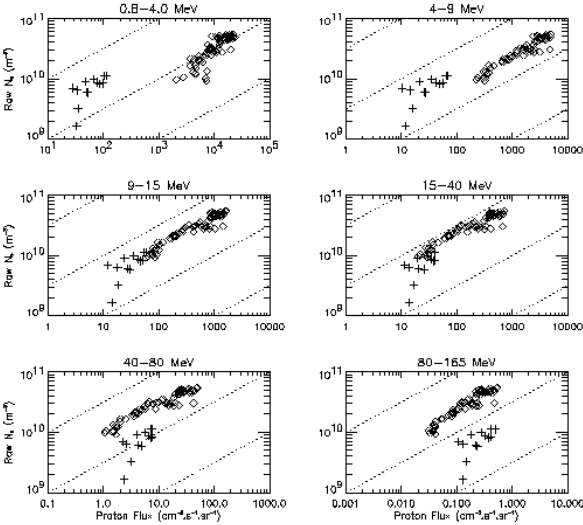
Fig. 6. Plots of electron density at 65km against the proton flux in 6 of 9 energy bands, daytime, 28 and 29 October represented by crosses and diamonds